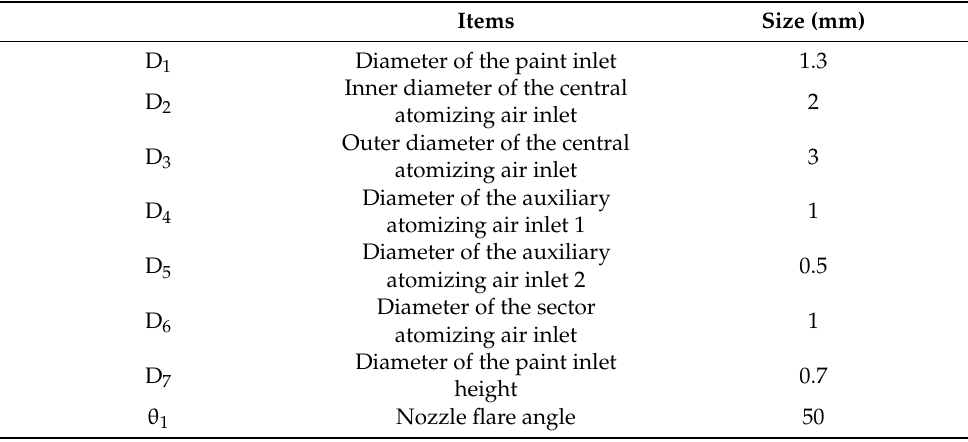
Figure 3. Sectional view of the air cap. Table 1. The parameters of the air